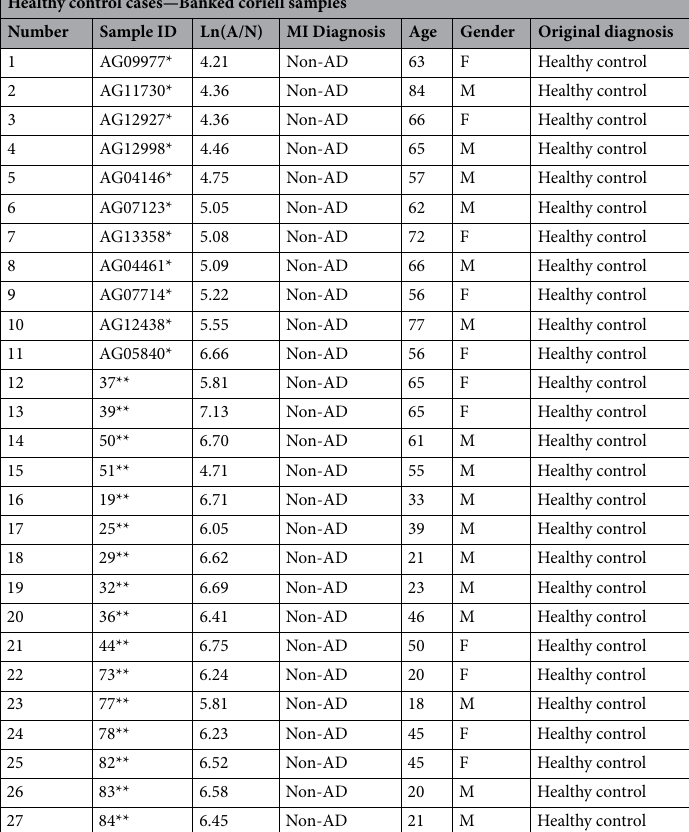
Table 3. Skin fibroblasts-based peripheral diagnosis of healthy control cases (N = 27). AD Alzheimer’s Disease, EEG Electroencephalogram, FAD Familial AD, FTD Frontotemporal dementia, FTLD Frontotemporal Lobar degeneration, LDB Lewy body dementia, PD Parkinson’s Disease, VaD Vascular dementia, CDB Corticobasal degeneration, FTLD-TDP Frontotemporal Lobar Degeneration with TDP-43-Positive Inclusions, HD Huntington disease, PD, LDB Lewy body disease, PD Parkinson Disease, VaD Vascular dementia, Coriell Coriell Institute, CRI Copper Ridge Institute, UTSW University of Texas South Western, WHM William Hill Manor. *Banked Coriell Samples; **Freshly Obtained from the Clinic Alere